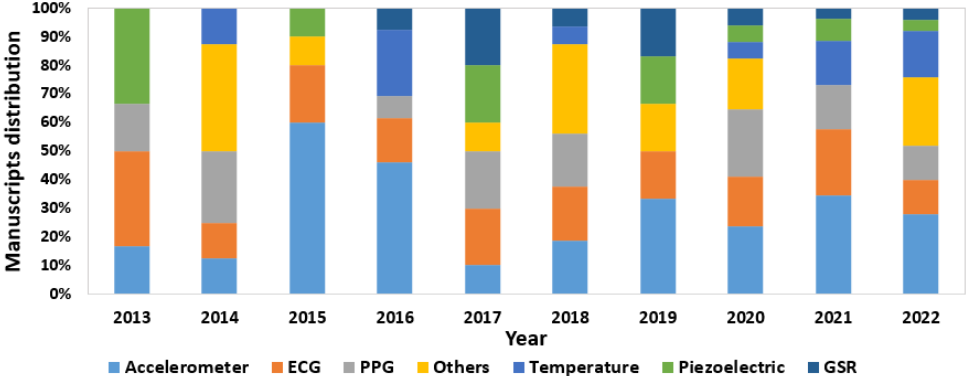
Figure 17. Distribution of sensors used in published manuscripts by year.